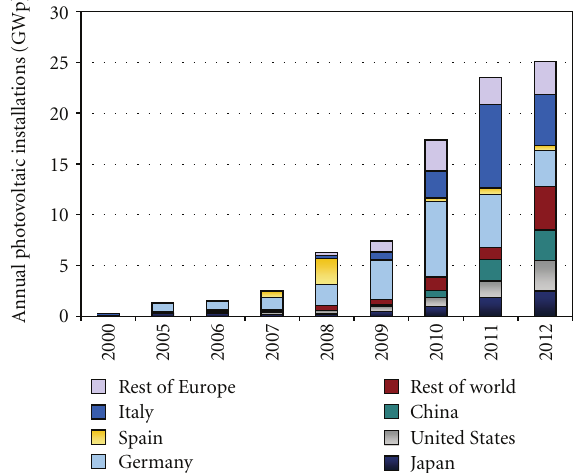
Figure 2: Annual photovoltaic installations from 2000 to 2012. 2011 and 2012 are still estimates. (data source: Bank Sarasin [4], EPIA [5], EurObserv’ER [6], and own